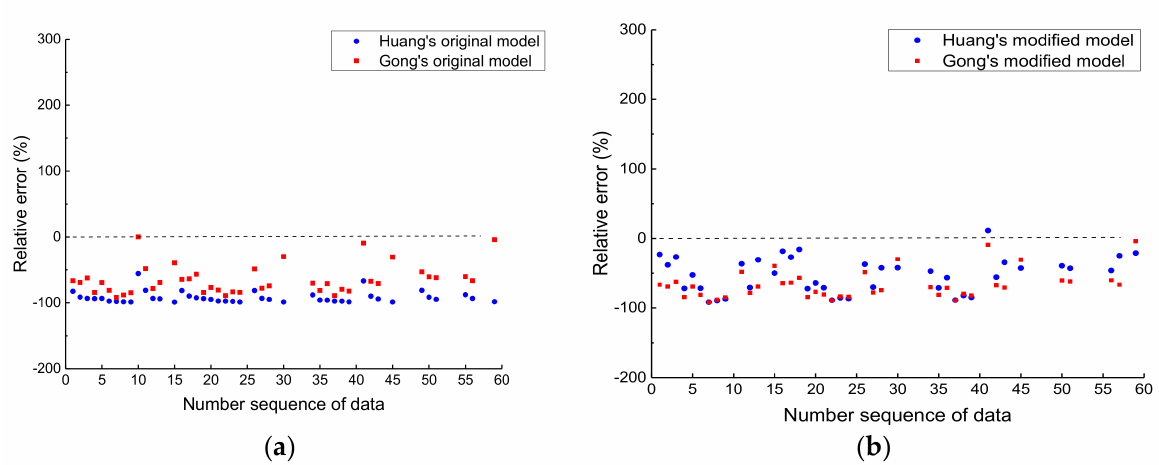
Figure 1. Comparison of relative errors between Gong L.S. model and Huang S.Y. model: ( a ) Original model; ( b ) Correc- tion